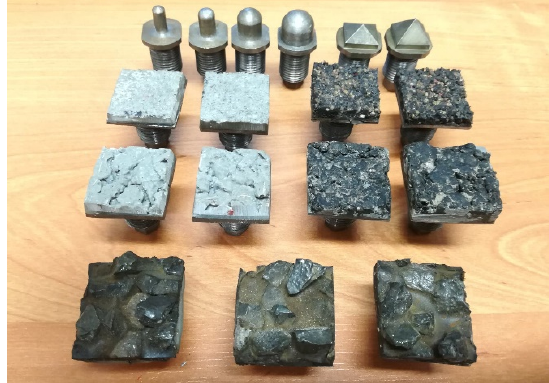
Figure 9. Different penetrators used in this study.